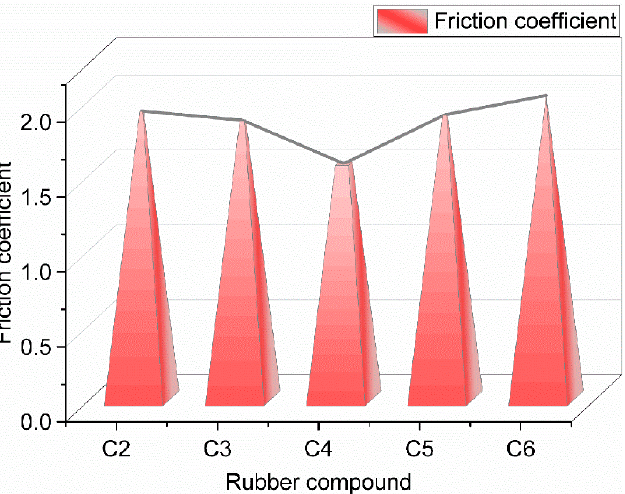
Figure 10. The average coefficient of friction of GF/rubber composites with different ratios against metal.